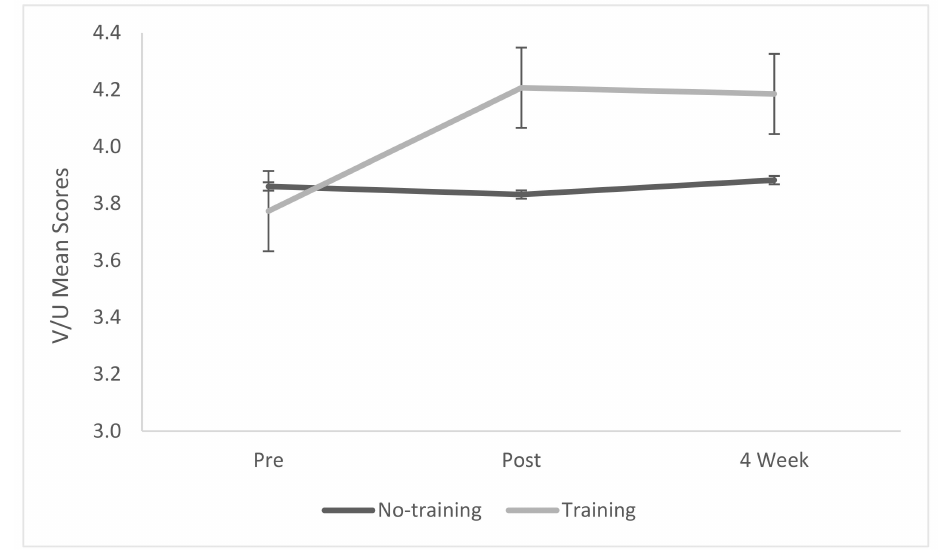
Figure 3. Mean scores of the Intrinsic Motivation Inventory subscale value and